Question: How would you classify this visualization?
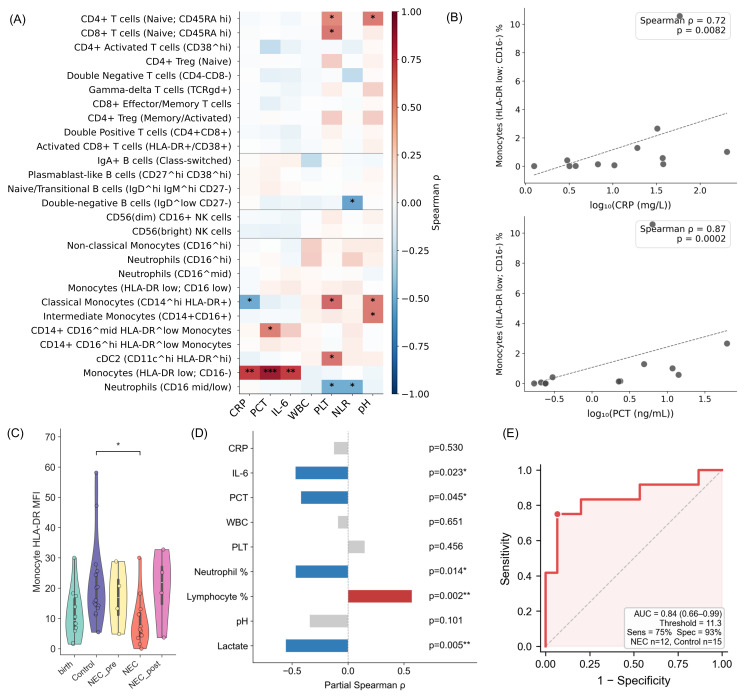
Answer: heatmap